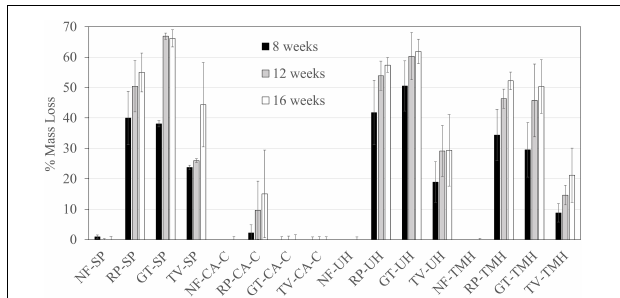
FIGURE 1 | Mass loss percentages after 8, 12, and 16 weeks of decay for thermally modified western hemlock (TMH), untreated western hemlock (UH), copper azole-treated southern pine (CA-C), and southern pine (SP) degraded by Rhodonia placenta (RP), Gloeophyllum trabeum (GT), or Trametes versicolor (TV). Error bars are one standard deviation of 10 replicate